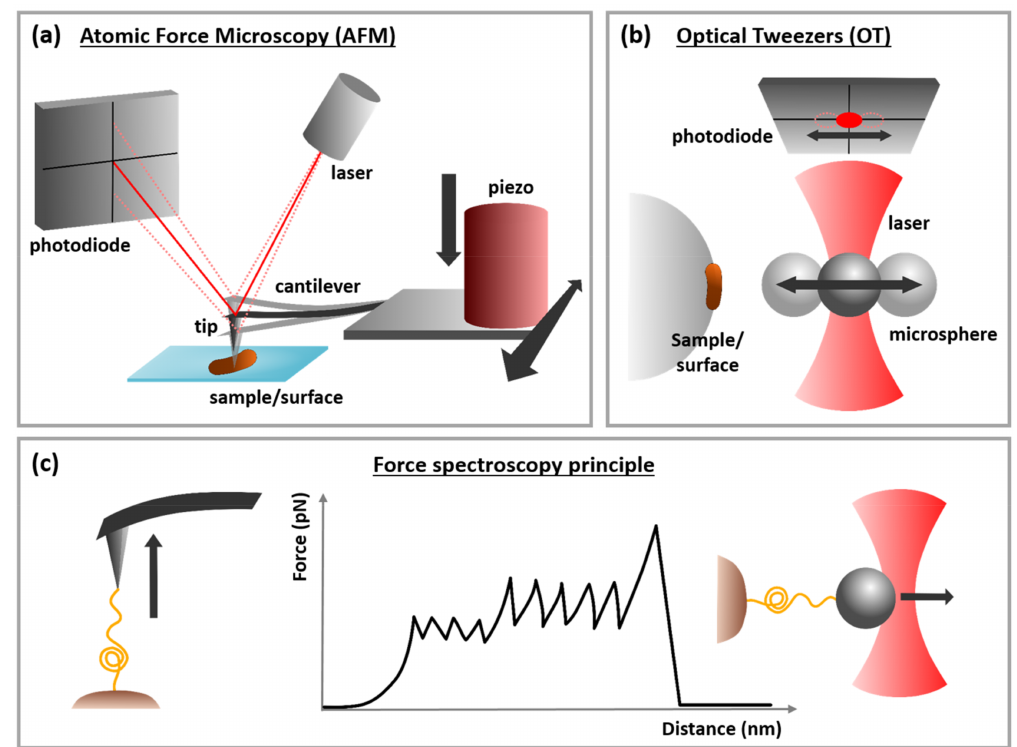
Figure 1. Atomic force microscopy, optical tweezers and force spectroscopy principles. ( a ) AFM principle: a sharp tip is mounted on a cantilever that can be moved in the x, y, and z direction thanks to a piezo-electric ceramic. A laser beam reflected on a photodiode allows recording the deflection of the cantilever. Reproduced with permission from [33]. ( b ) OT principle: A small bead is trapped in the waist of a focused laser beam. The beam transmitted/refracted by the trapped bead is reflected on a photodiode allowing to monitor the position of the small bead from the focus position. A large bead, on which a living cell is grafted, is immobilized on the microscope slide; an x, y, and z piezo stage moves it towards the trapped small bead in order to interact. ( c ) Force spectroscopy principle: both in AFM and OT, the probe interacts with a molecule present at the surface of the sample, and then is retracted from the sample, which leads to the unfolding of this molecule. When the retraction force is high enough that a molecular bond within the molecule is broken, a retract adhesion peak appears on the force curve (middle scheme). When several intramolecular bonds are broken successively, several retract adhesion peaks are visible on the force curve. The force needed to break the bond can be measured directly on the force curve, as well as the length of the unfolded